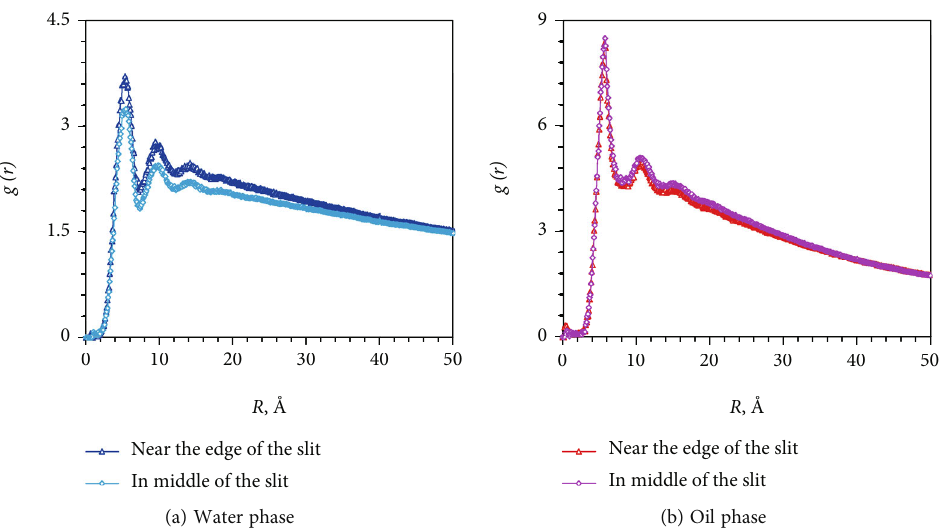
Figure 10: RDF of fl uid in di ff erent parts of the slit of model 8.